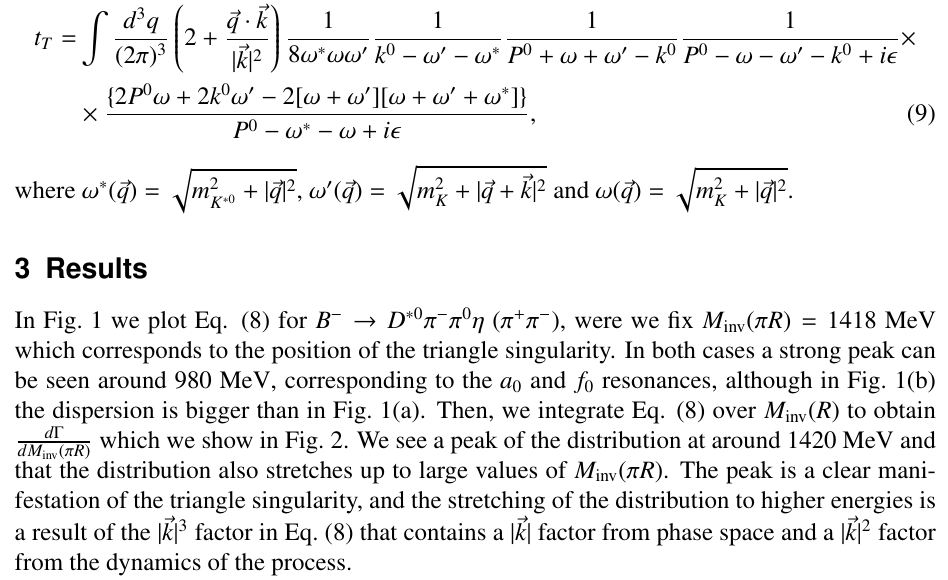
with (see Refs. [5] and [16])